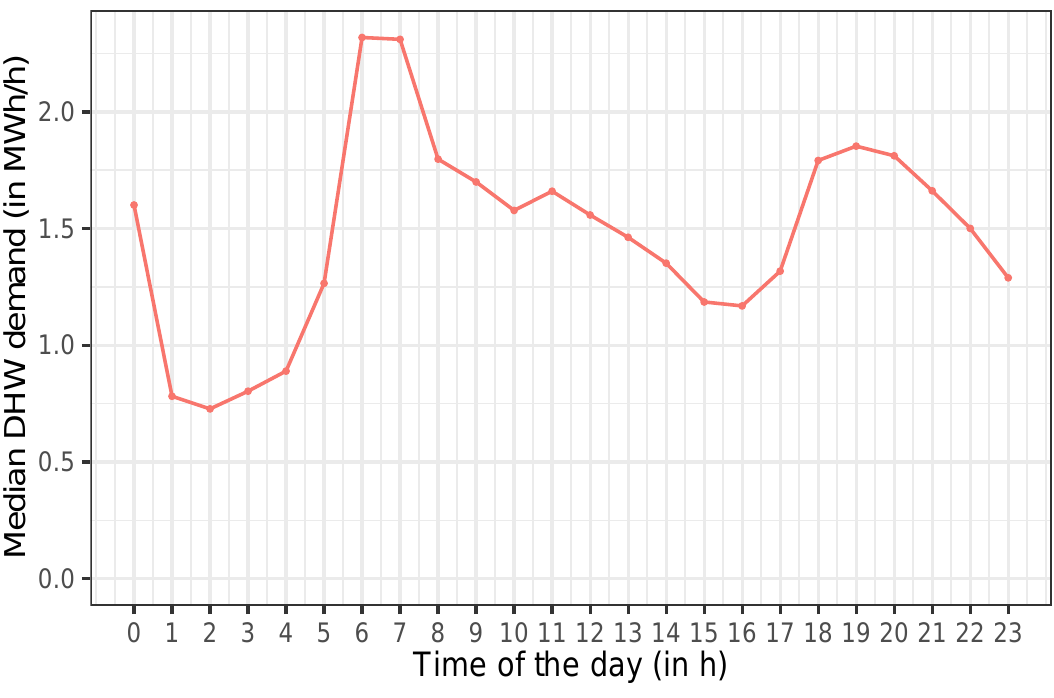
Figure 2. Hourly median heat demand in the REFUNA grid for the period 9–15 July 2010, when daily minimum temperatures did not drop below 18 °C. This profile is taken as the hourly domestic hot water (DHW)